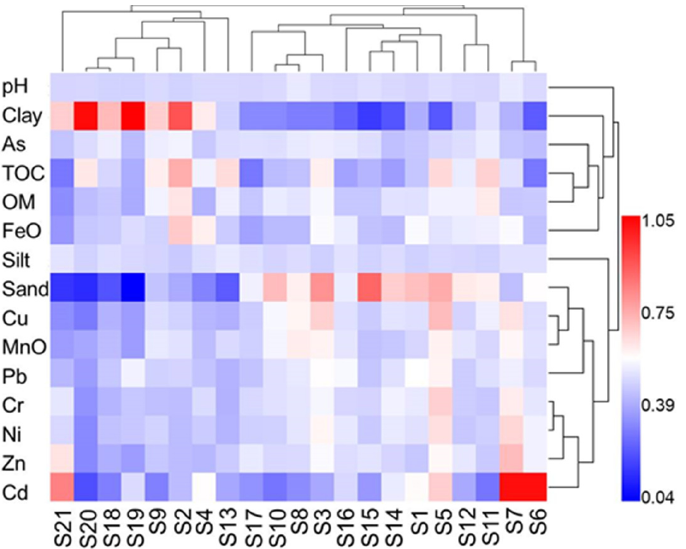
Figure 6. Two-way hierarchical cluster analysis for the heavy metals, sampling sites, and properties of sediments.